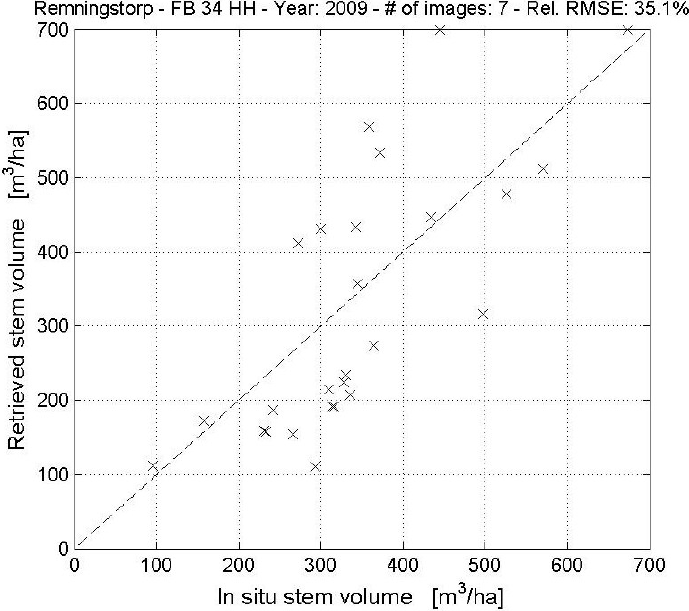
Figure 12. Scatter plot of retrieved stem volume with respect to in situ stem volume in the case of all HH-polarized images acquired during 2009 over Remningstorp with a look angle of